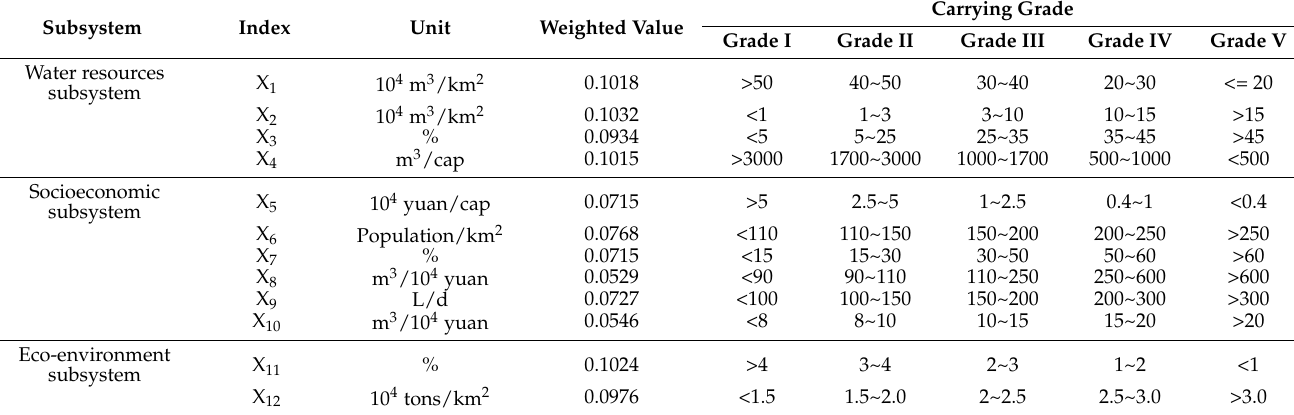
Figure 3. Relationship between subsystems and indices with their weights. Table 3. Estimated evaluation index weights and classification standards of the WRCC in the Han River